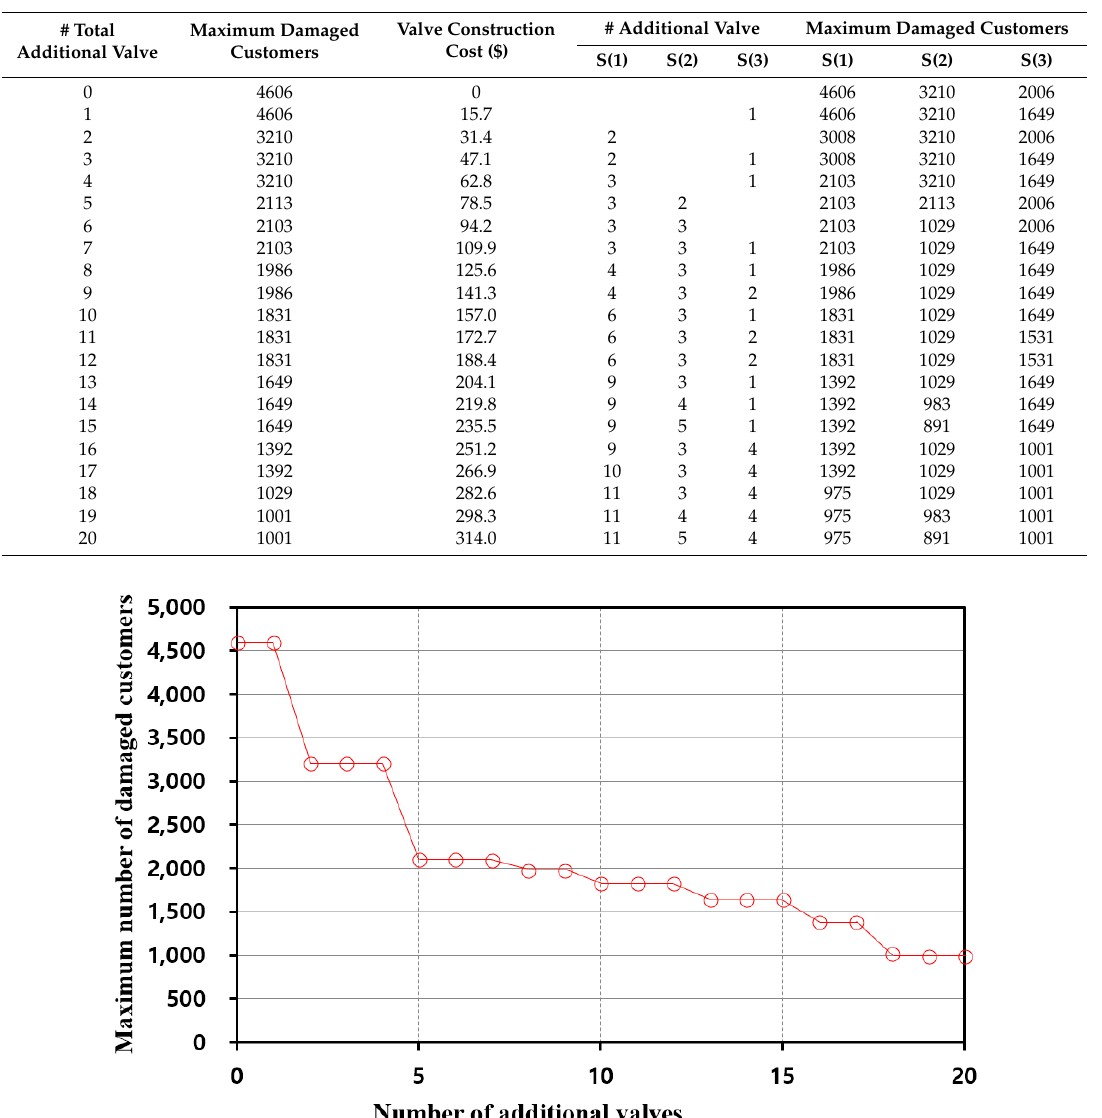
Table 11. Effect of damage reduction by increasing the number of additional valves in G-city network.